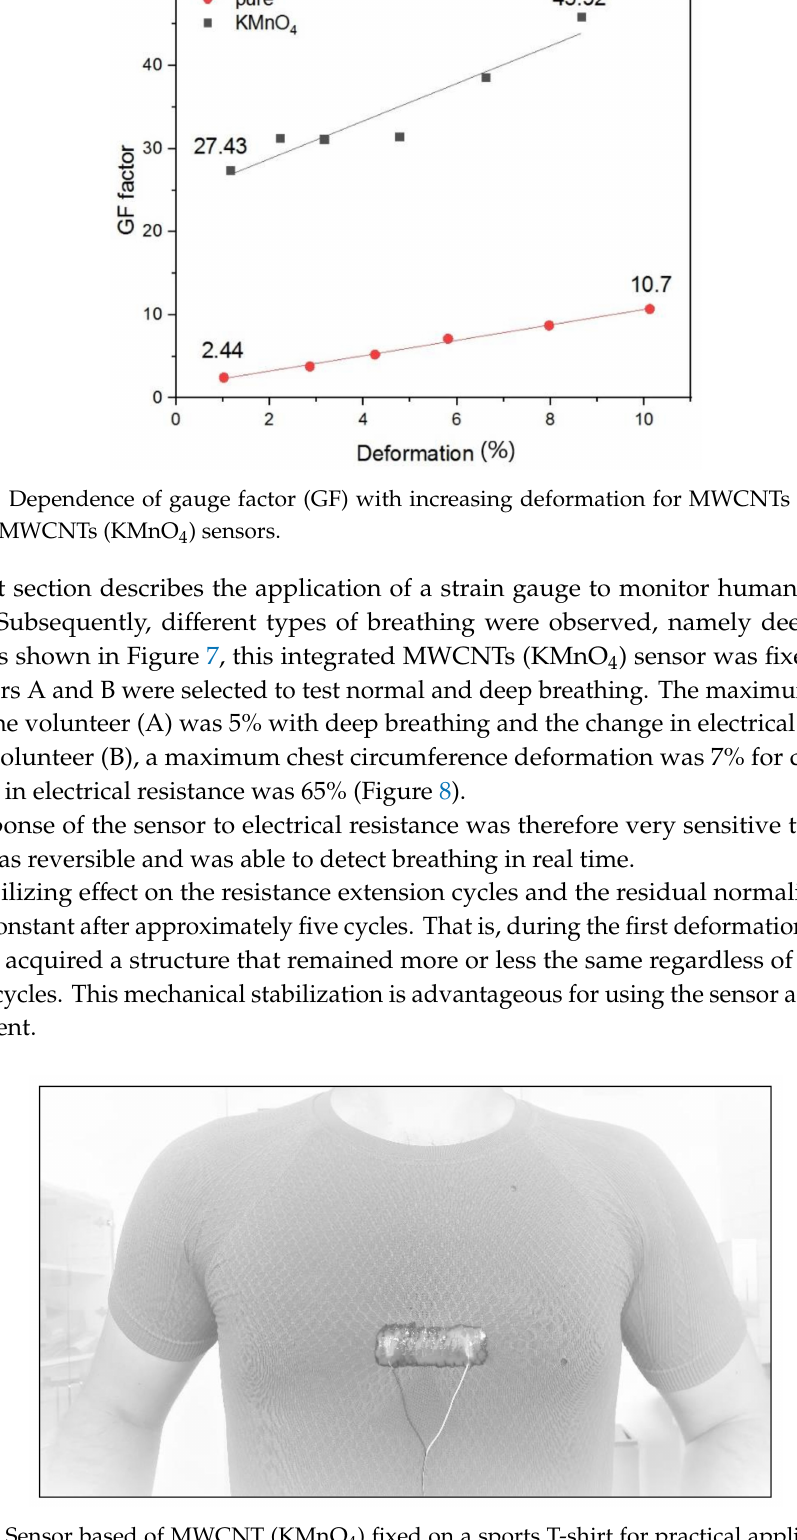
Figure 7. Sensor based of MWCNT (KMnO 4 ) fixed on a sports T-shirt for practical application of a human breath